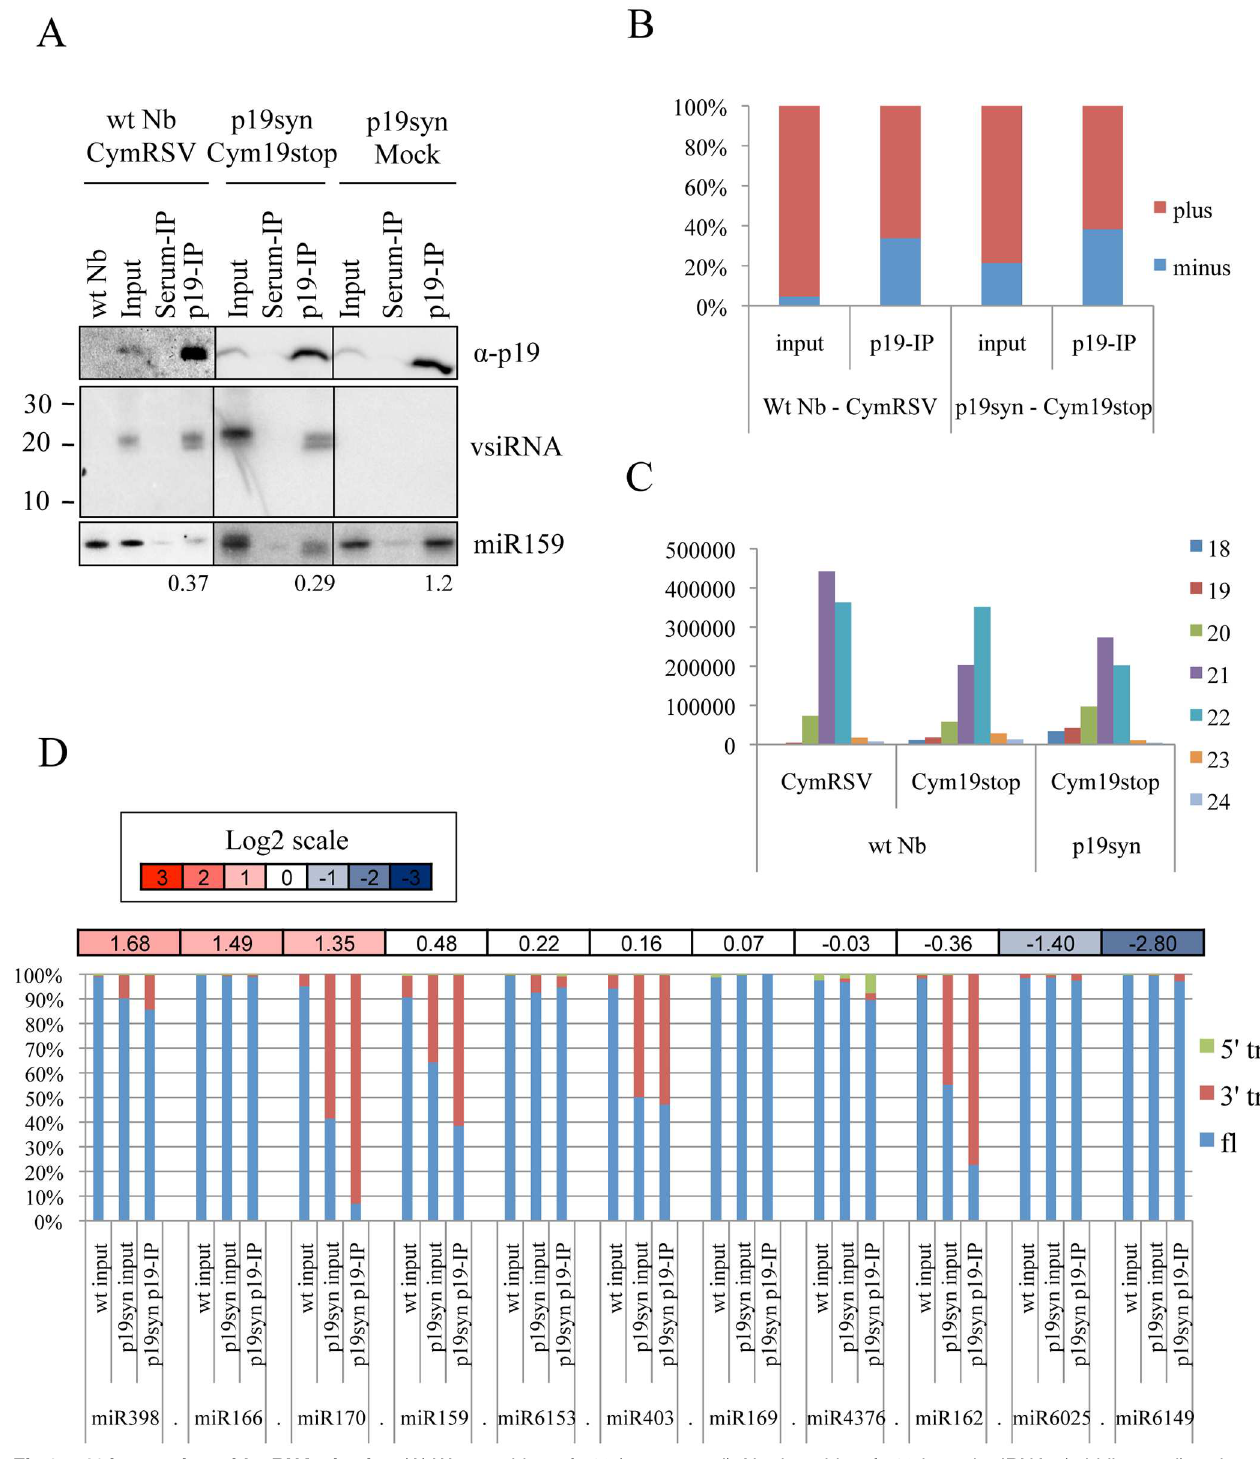
Fig 3. p19 interaction with sRNAs in vivo . (A) Western blots of p19 (upper panel), Northern blot of p19-boundvsiRNAs (middle panel) and miR159 (lower panel) during the CymRSV and Cym19stop virus infection of p19syn and wt N . benthamiana plants as indicated.The ratio of p19-boundmiR159 to the input (IP/input) is indicatedbelow the panels. (B) The percent of vsiRNA sequencesderived from the positive and negative viral strands in the input and in p19-IP. (C) Global accumulationof different size classes of vsiRNAs in p19syn and wt N . benthamiana plants infected by CymRSV and Cym19stop as indicated. Size classes of vsiRNAs are shown by color codes presented on the right side of the